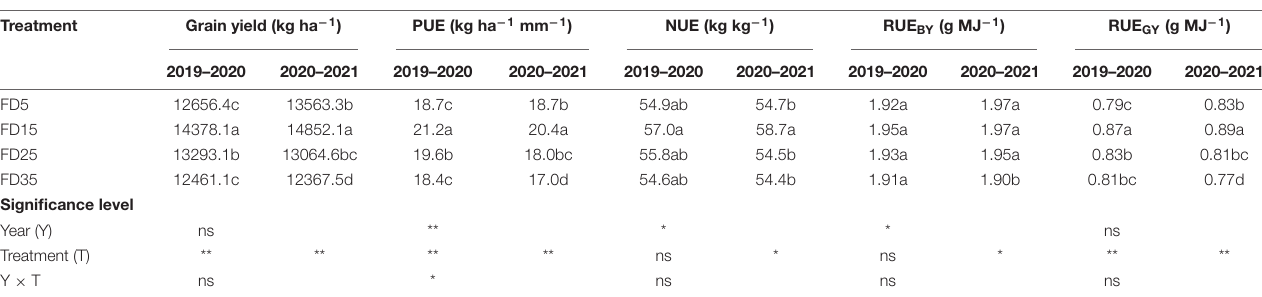
TABLE 3 | Annual grain yield, PUE, NUE, RUE BY , and RUE GY .